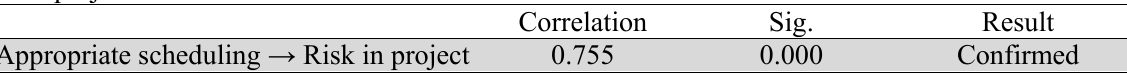
The results of testing the relationship between risk in industrial projects and an appropriate scheduling of the projects